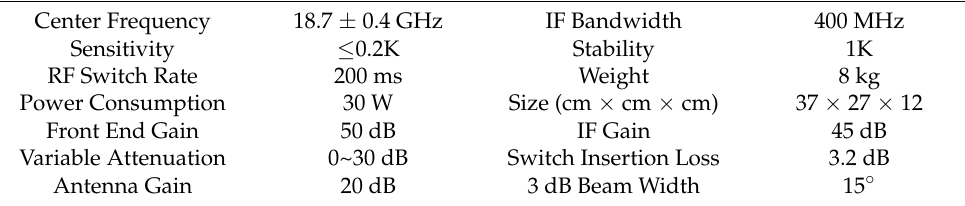
Figure 2. The block diagram of an AGC microwave radiometer. Table 2. Parameters of the microwave radiometer receiver.